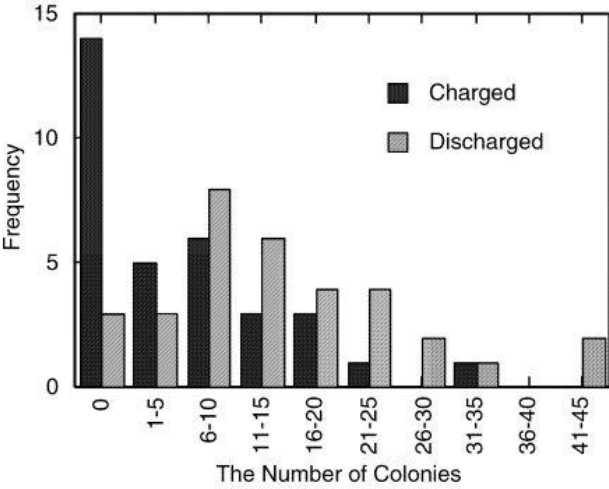
Figure 12. Bactericidal e ff ect of the photoelectrochemically charged (irradiated with UV light for 24 h) and pre-discharged TiO /WO films. A 20 μL aliquot of E. coli suspension 2 3 that contains ~70 cells was applied onto a film surface, and left for 6 h at room temperature, 100% relative humidity. The suspension was then transferred onto a deoxycholate agar culture medium and incubated for 24 h at 37 °C. The number of thus formed colonies was counted [28]. Reproduced with permission from Elsevier, ©